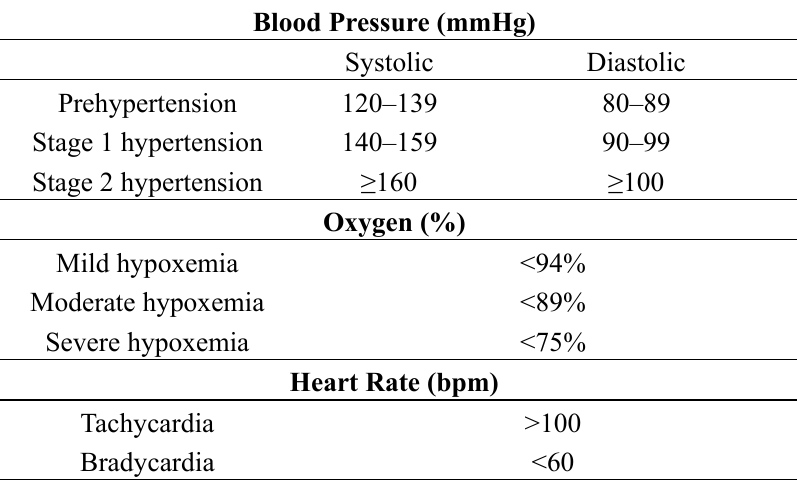
Table 1. The blood pressure, oxygen, and heart rate standards.